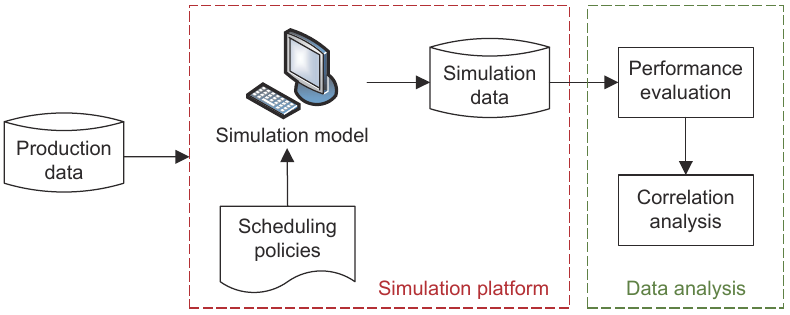
Fig. 2 Framework of the performance evaluation and correlation